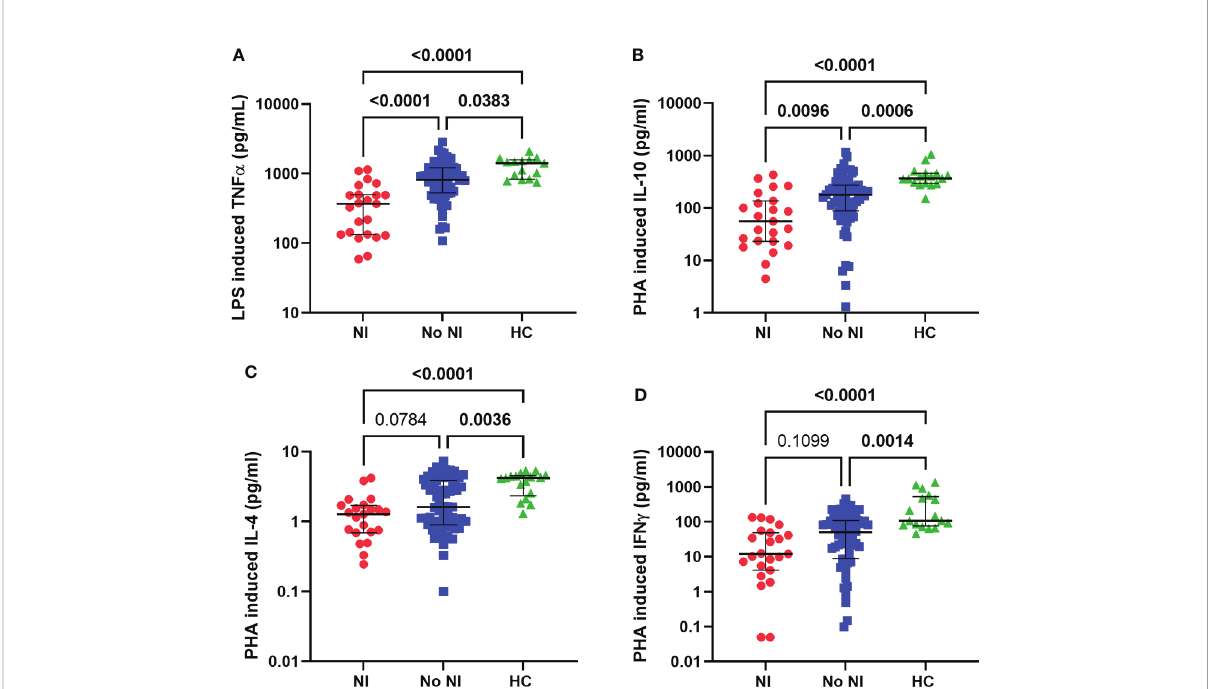
FIGURE 3 Immune function within the fi rst 72 hours following pediatric thermal injury. Innate and adaptive immune function were measured by ex vivo LPS and PHA stimulation, respectively. Within the fi rst 72 hours of injury, LPS induced TNF a (A) was decreased for all burn subjects (NI, n=23 and No NI, n=66) compared to healthy controls (n=15). PHA-induced cytokine-production capacities (B – D) were decreased for all burn subjects (NI, n=23 and No NI, n=67) compared to healthy controls (n=17). Subjects who went on to develop an infection had signi fi cantly lower LPS induced TNF a (A) and PHA induced IL-10 (B) compared to those who recovered from burn injury without developing an infection. Statistical analysis was performed using one-way ANOVA plus Dunn ’ s test. Lines represent median and interquartile range; dots represent the individual data points. NI, nosocomial infection (red); No NI, no infection (blue); HC, healthy control